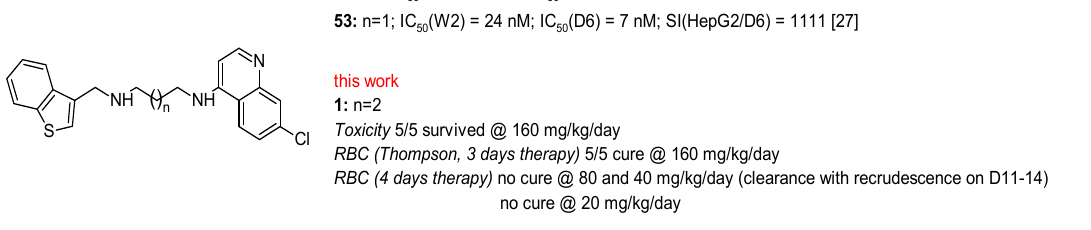
Figure 2. Antimalarial activity of compounds 1 and 53 . RBC—red blood cell. Molecules 2017 , 22 , 343